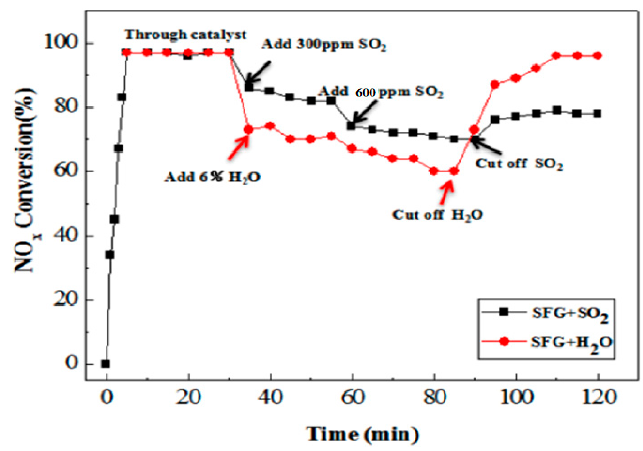
Figure 9. The influence of SO 2 and H 2 O on de-NO x performance over the Ce-Mn-Fe/GO-20% sample.